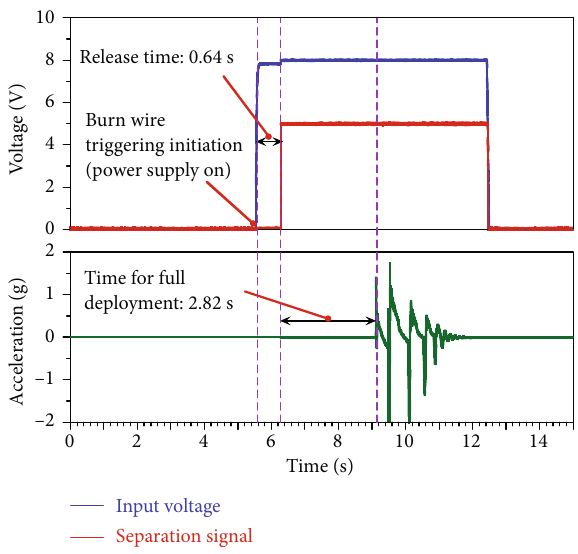
Figure 9: Release times of the solar panel during repetitive release function tests of the